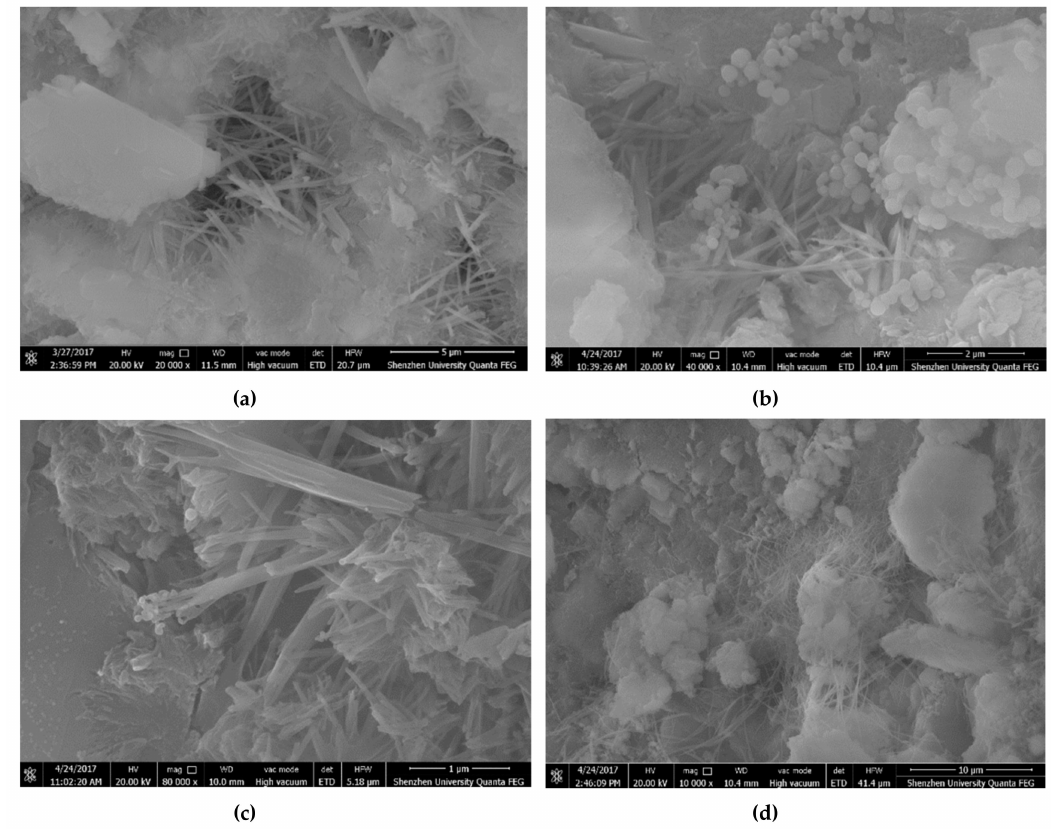
Figure 8. SEM image of concrete specimens with addition of nano-Fe 2 O 3 ( a ) 0%; ( b ) 3%; ( c ) 5%; ( d ) 10%. Reprinted with permission from [89]. Copyright © 2018, Atlantis